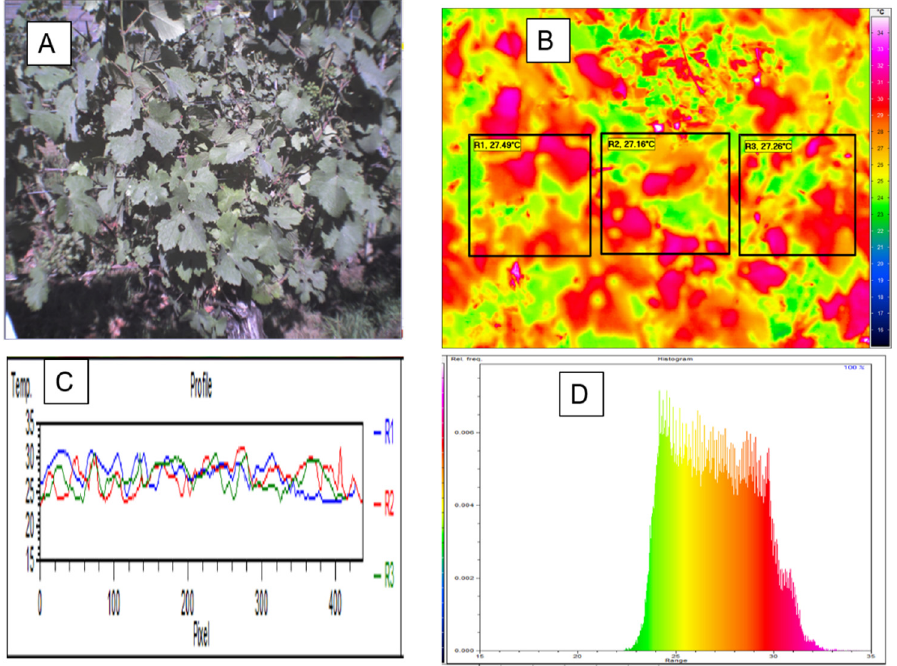
Figure 2. Canopy temperature measurement, RGB image ( A ), thermal image ( B ), temperature profile ( C ), and histogram ( D ).